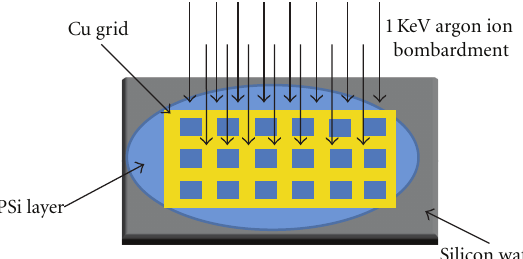
Figure 1: Schematic representation of the photonic crystal struc- ture fabrication process.